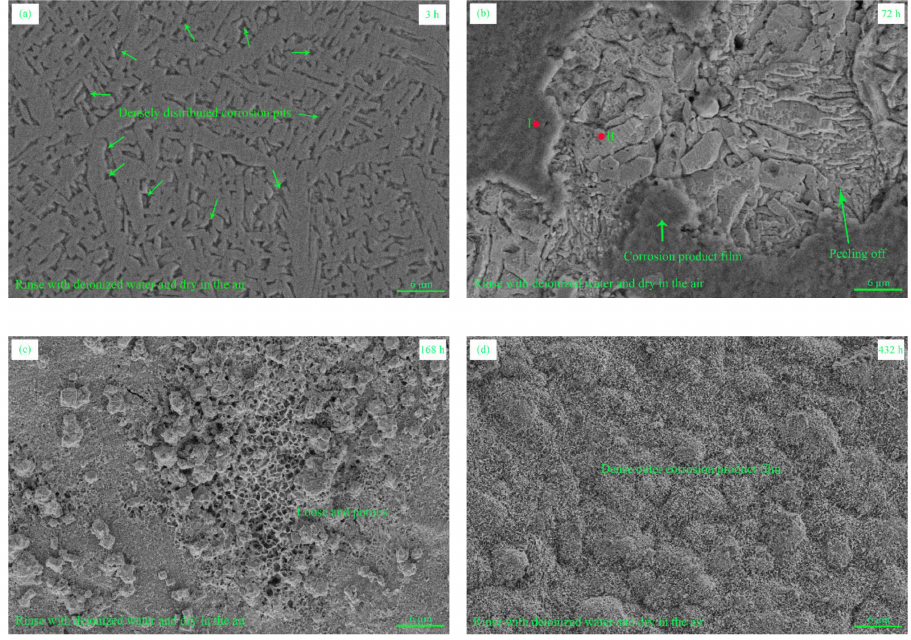
Figure 7. SEM images of WRS immersed in 3.5% NaCl solution at di ff erent times: ( a ) 3 h; ( b ) 72 h; ( c ) 168 h; ( d ) 432